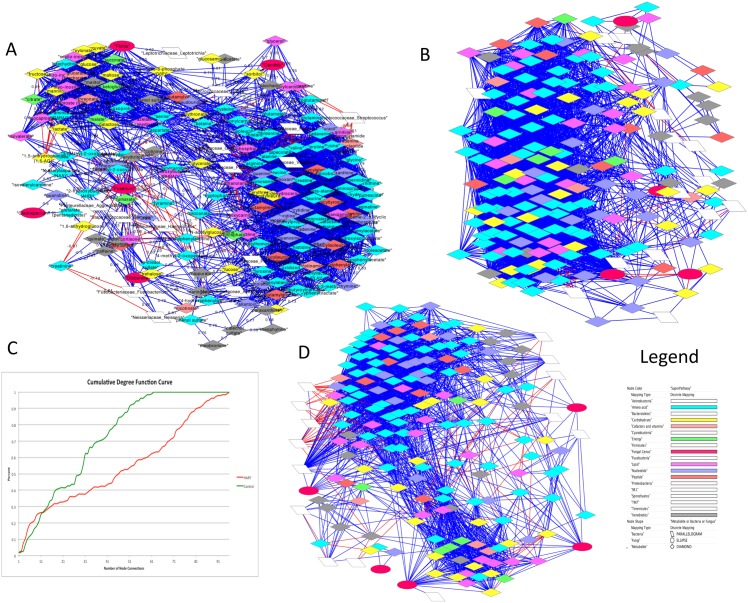
Correlation networks for Control and HIV cohorts.The legend is common for figures A, B and D: The correlation network represents features that are linked with a correlation coefficient greater than 0.6 (negative or positive) and with a p value <0.05. Parallelograms represent bacterial taxa, ellipses represent fungi and diamond shapes represent metabolites. Red edges represent a negative correlation between connected nodes and blue edges present positive correlations. A: Control correlation network with r. >0.6 or r.< -0.6 and p value <0.05. B: correlation network with +.0.6 < rho <-0.6 and p value <0.05. C: Cumulative Distribution Function D: Is the difference network map of 1A and 1B. It depicts those nodes that have a correlation with 0.6 < rho <-0.6 in either the control or HIV cohort, but not both.